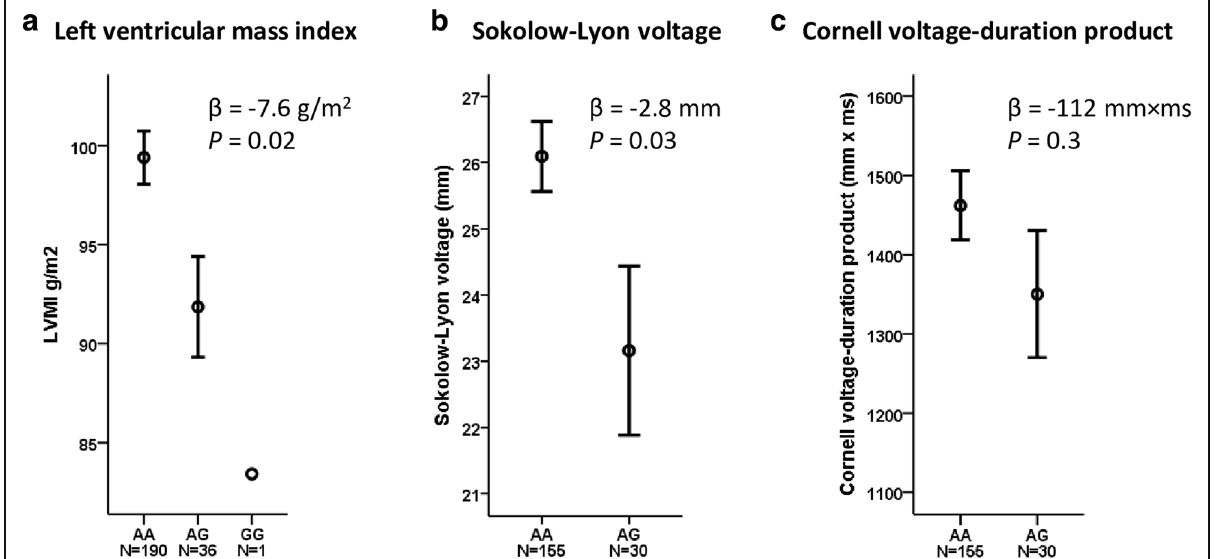
Fig. 3 Markers of LVH according to rs4905794 genotypes in GENRES. ( a ) LVMI ( n =227), ( b ) Sokolow-Lyon voltage ( n =185) ( c ) Cornell voltage-duration product ( n =185). Error bars indicate standard error of means. Abbreviations: LVH, left ventricular hypertrophy; LVMI, left ventricular mass